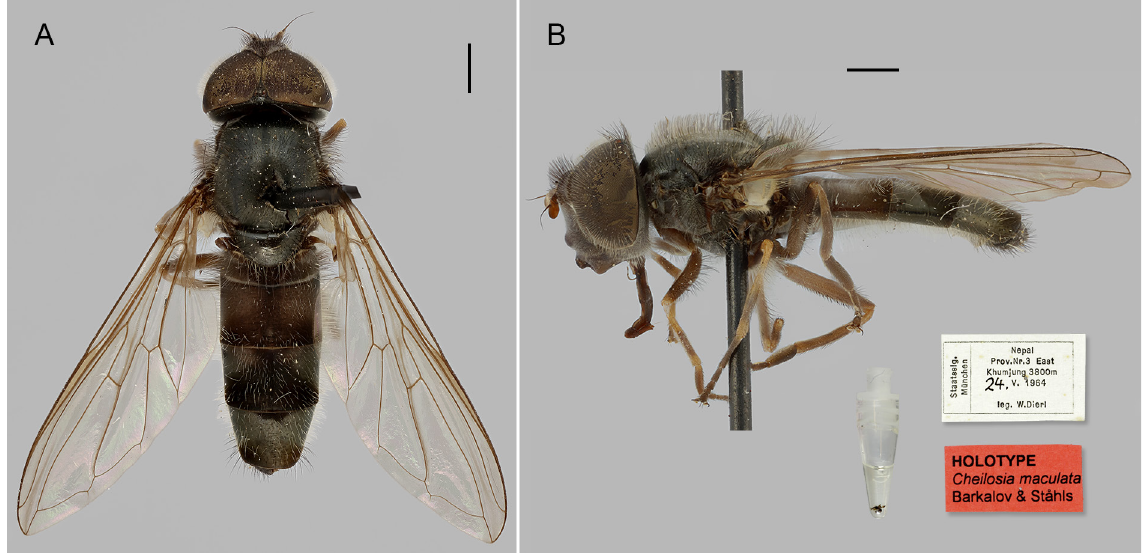
Fig. 40. Cheilosia ( Cheilosia ) maculata sp. nov., holotype, ♂ (ZSMC); dorsal and lateral views. Photo: Pekka Malinen, FMNH Luomus. Scale bars = 1